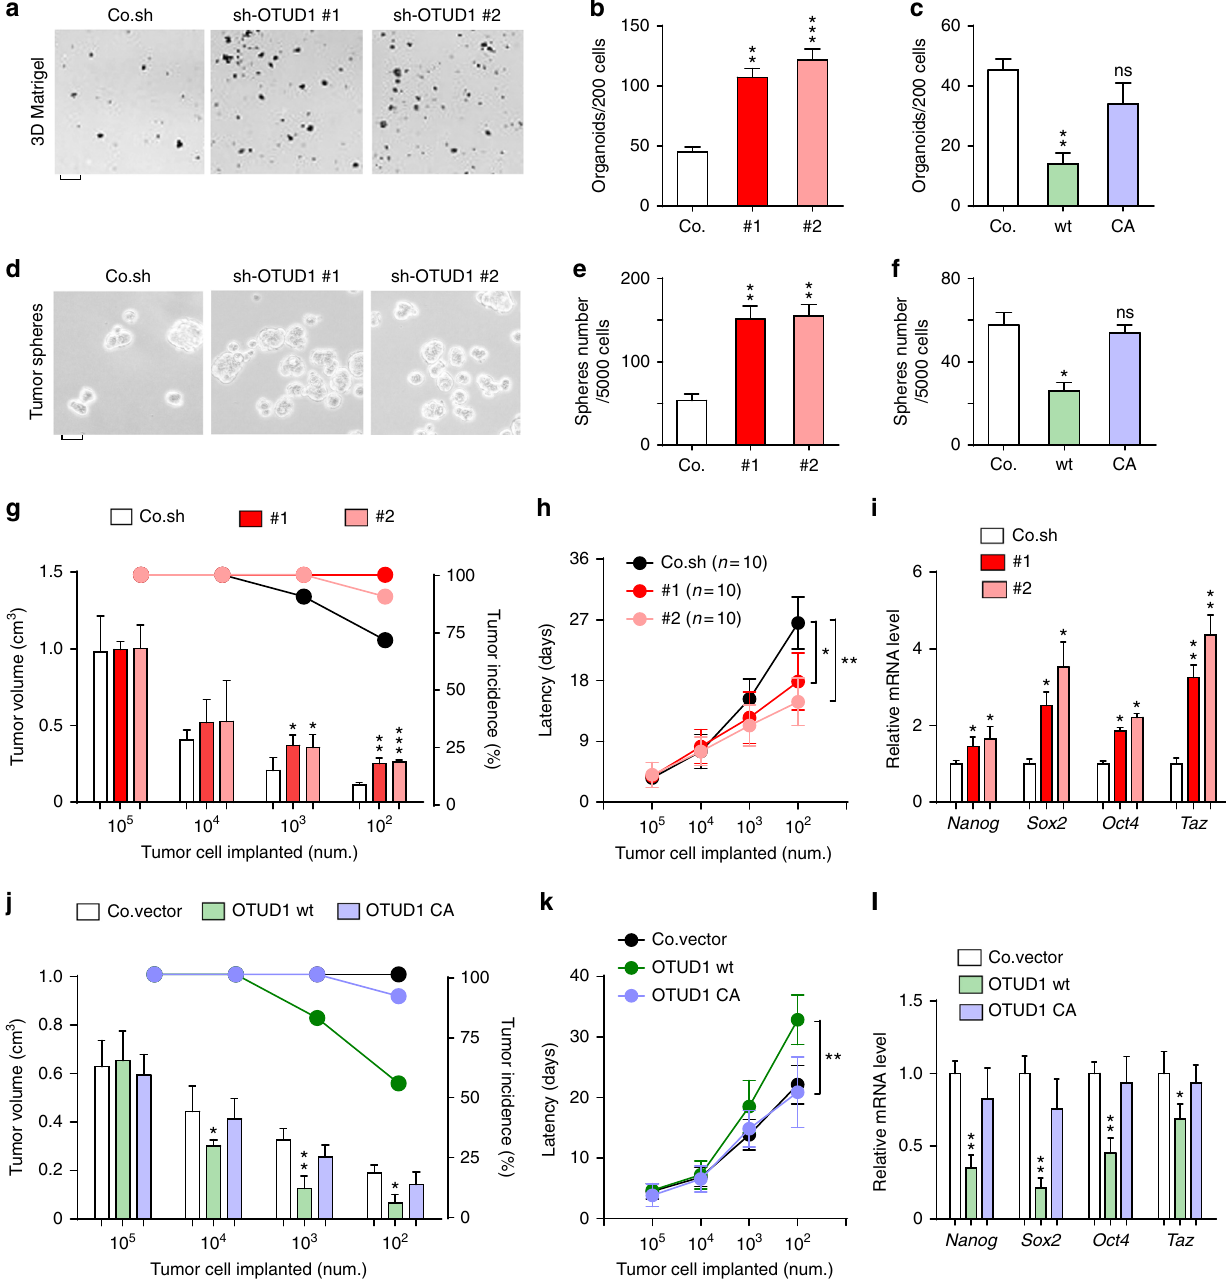
Fig. 2 OTUD1 inhibits cancer stem cell traits. a , b Control and OTUD1-silenced MCF10A-RAS cells were cultured in 3D Matrigel. Representative wells a (scale bar, 2 mm) and mean number of organoids ( ± SE) per 200 cells from triplicate samples b . c Mean number of organoids ( ± SE) per 200 cells from triplicate samples of control and OTUD1-wt/CA overexpressed MCF10A-RAS cells cultured in 3D Matrigel. d , e Control and OTUD1-silenced MCF10A-RAS cells were analyzed in a tumor sphere assay. The pictures show representative images of tumor spheres ( d , scale bar, 500 μ m), and the graph shows the number of tumor spheres per 5×10 3 cells seeded e . f Mean number of tumor spheres per 5×10 3 cells from triplicate samples of control and OTUD1-wt/CA overexpressing MCF10A-RAS cells. g Control and OTUD1-shRNA silenced MCF10A-RAS cells were subcutaneous injected into nude mice at the indicated numbers. Mean of tumor volumes at week 5. h Tumor latency at indicated cell number of cells described in g . i Control and OTUD1-silenced MCF10A-RAS cells were subjected to qPCR analysis. j Control MCF10A-RAS cells or cells stably expressing OTUD1-wt or OTUD1-CA were subcutaneous injected into nude mice at the indicated numbers. Mean of tumor volumes at week 5. k Tumor latency at indicated cell number described in j . l Control MCF10A-RAS cells or cells stably expressing OTUD1-wt or OTUD1-CA were subjected to qPCR analysis. Error bars, mean ± SD. * p < 0.05, ** p < 0.01, and *** p < 0.001 (two-tailed Student ′ s t -test b – l )